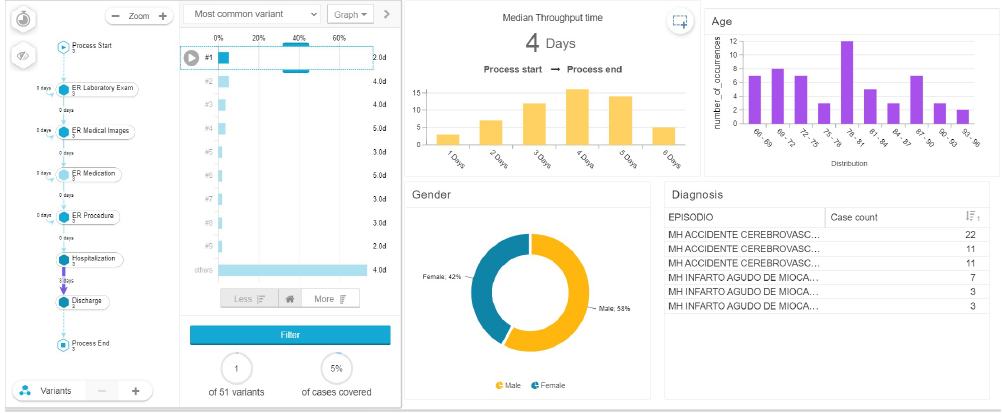
Figure 10. Variant and short stay for AMI